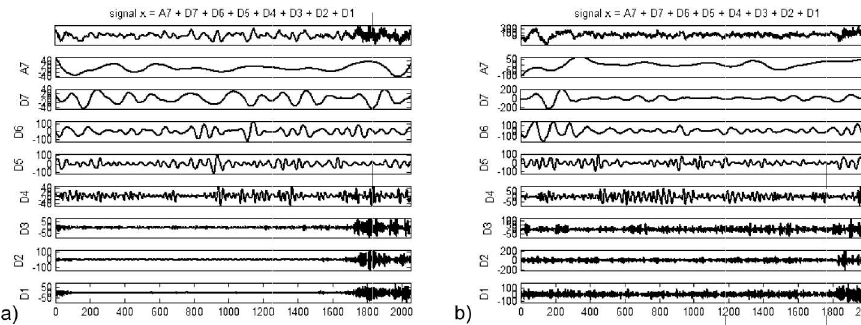
Figure 2. Multi-resolution signal analysis of discharges: D1-D7 details, A7 – approximation from channels a) F7-T7, b) F8-T8